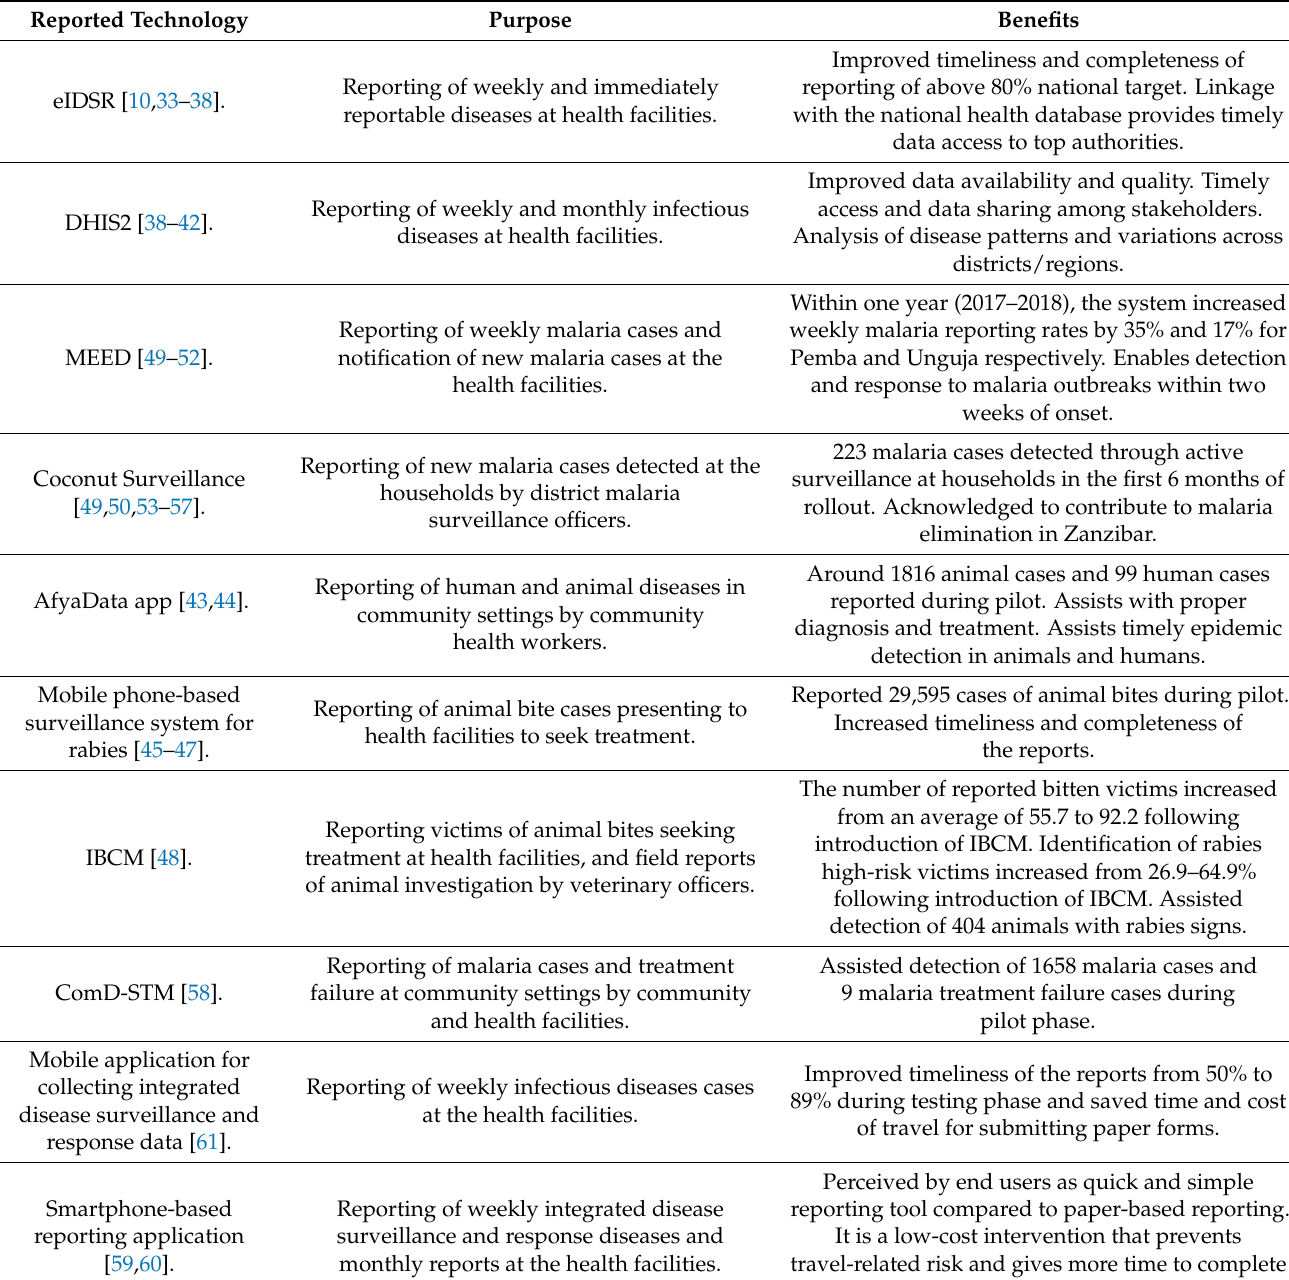
Table 5. The purpose and benefits of mobile phones and computer-based systems identified from the literature